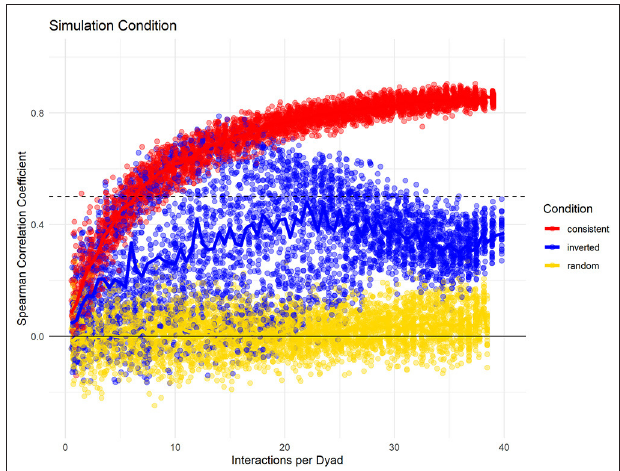
FIGURE 5 | Data simulation changes potential changes of interaction distributions throughout the dataset while having consistent group size, data density, and fidelity of dyadic preference. “Consistent Choice” indicates no changes in preferences throughout, “Inverted Choice” indicates one reversal for all dyadic preferences, while random choice indicates that all partners were chosen with the same